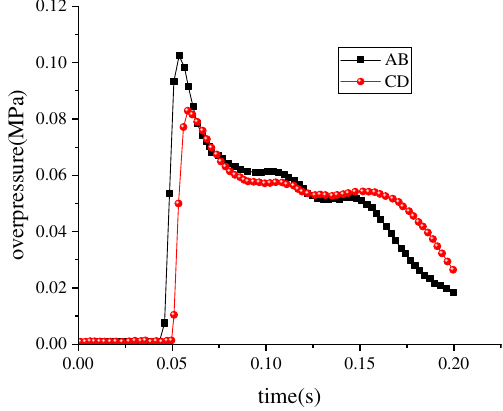
Fig. 13 Gas overpressure variation with time at different cross sections